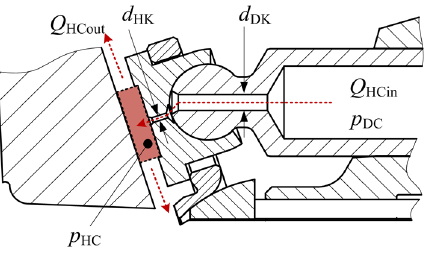
Figure 6. Control volume diagram of central oil